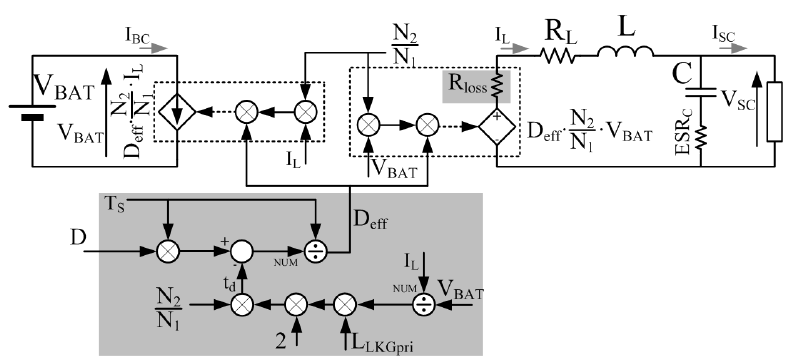
Figure 12. Full averaged large-signal model based on real components, parasitic elements, and